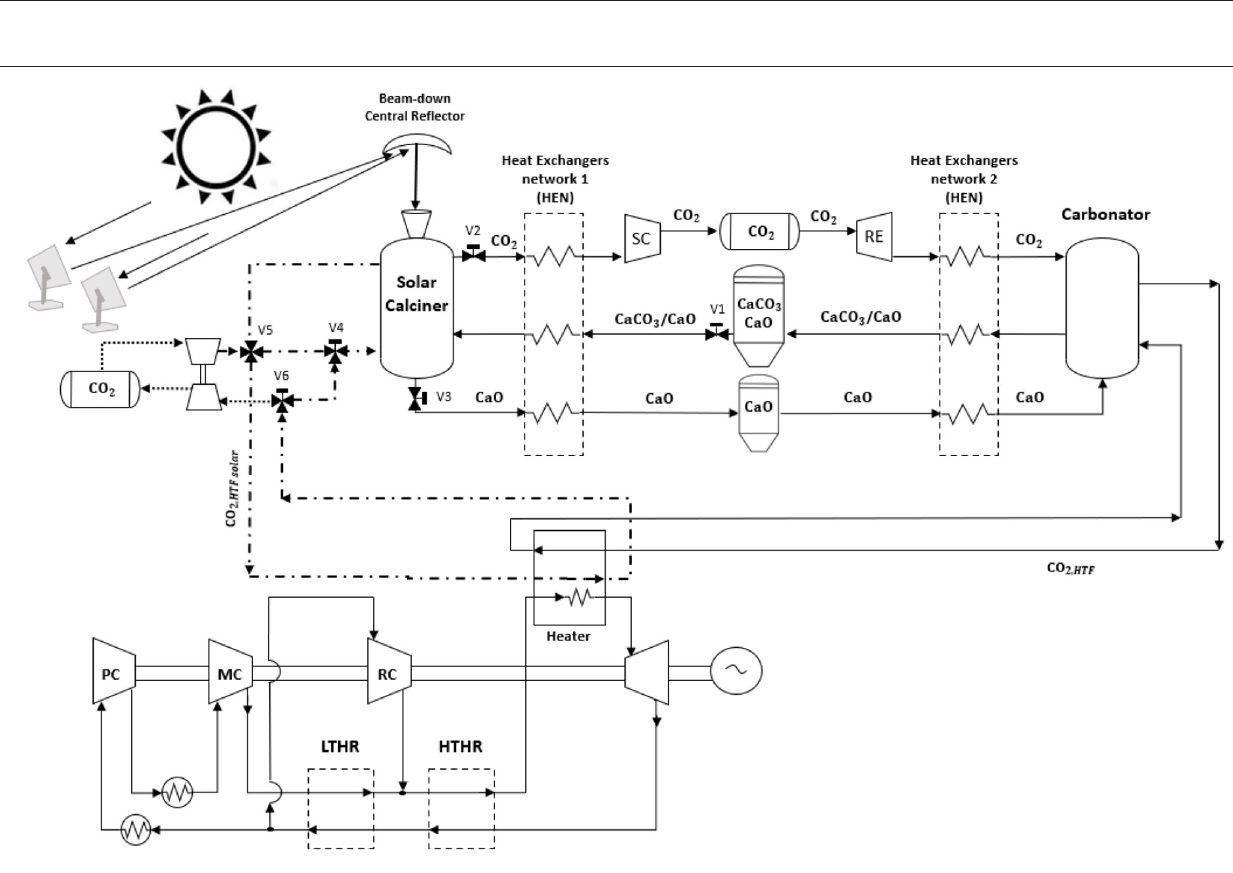
Frontiers in Sustainability |